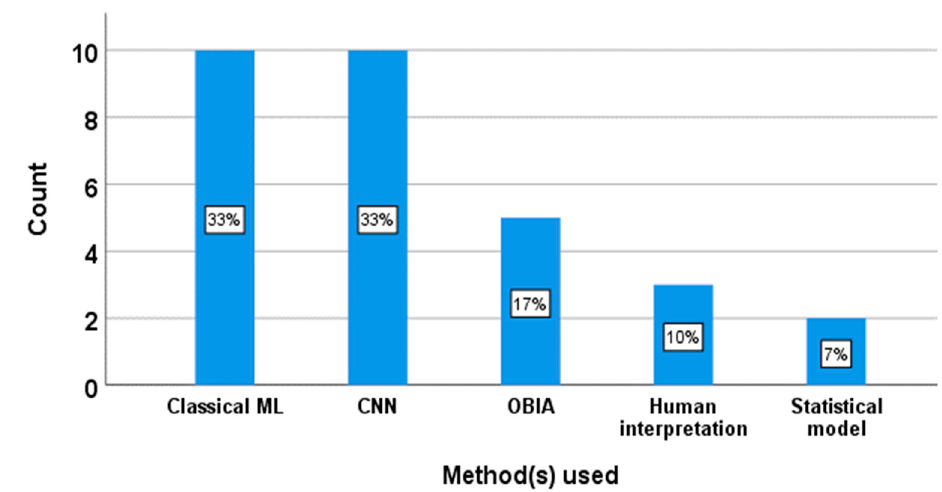
Figure 4. The methods used in key peer-reviewed articles on Earth observation-based deprived area mapping since 2016. ML: machine-learning, CNN: convolutional neural networks, and OBIA: object-based image analysis.